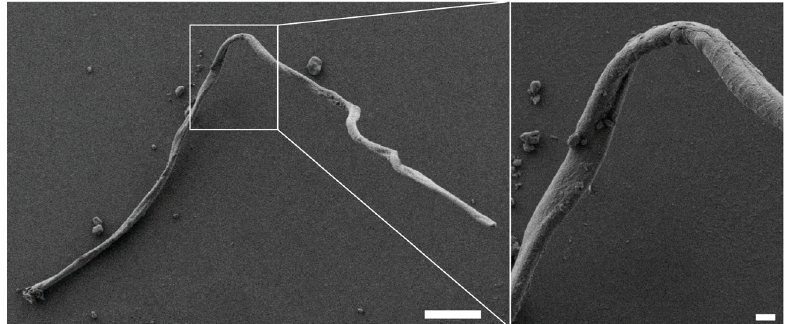
Figure 8. SEM image of a ChryC1 fiber, assembled after addition of four volumes of 100% ethanol (p.a.) to an aqueous solution of ChryC1. The image on the right depicts a magnification of the white frame on the left; scale bars: 100 μ m (left) and 10 μ m (right), respectively.